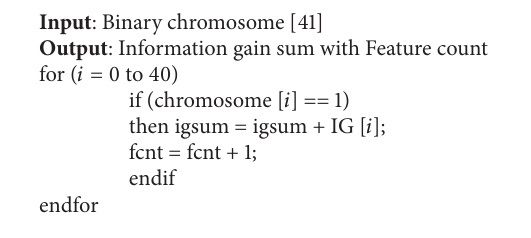
Algorithm 2: Maximum information gain with minimum feature count